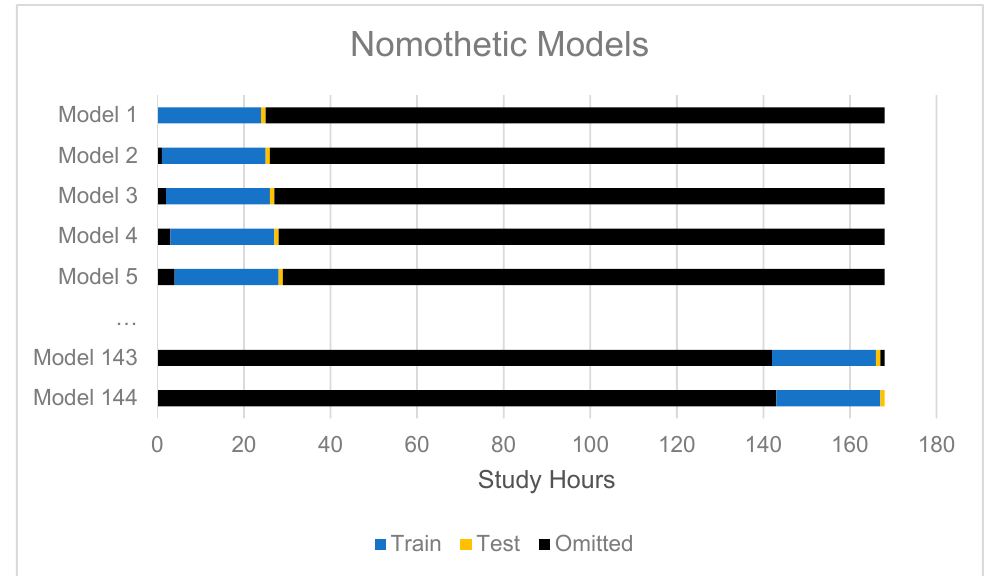
Figure 1. This figure describes the strategy for cross-validation for group-based nomothetic models. Note that the only the past 24 h periods were utilized to train the next hour, and a separate model was trained for each hour.